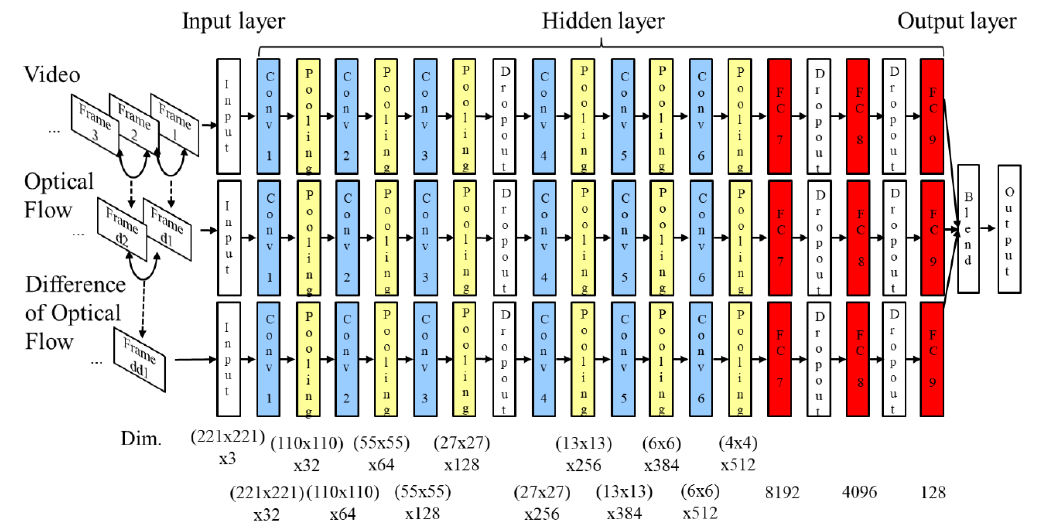
Figure 5. Deep neural network model for risk assessment.